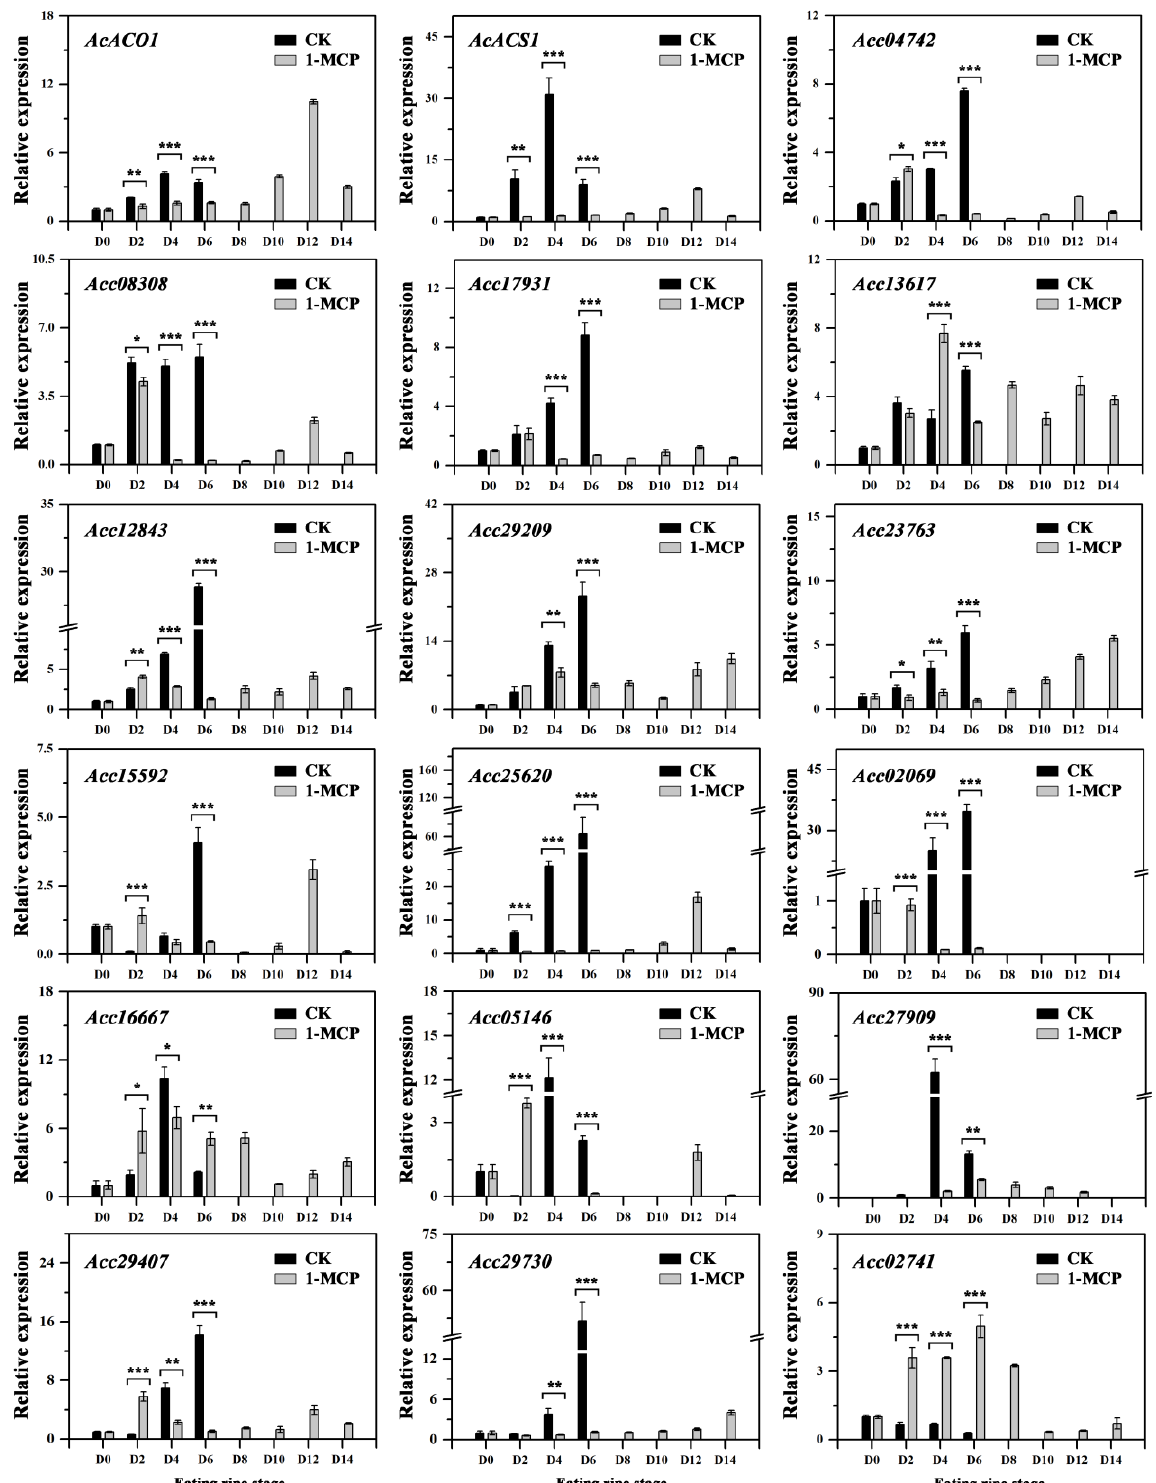
Figure 5. Expression of the ACO and ACS genes and ethylene-induced ERFs in the flesh of kiwifruit. Error bars show SE of the mean. Data were analyzed with Student’s t -test (* p < 0.05, ** p < 0.01, *** p < 0.001). It is well-known that the AP2/ERF transcription factors (TFs) play an important role in the response to 1-MCP treatment [6]. In this study, 153 individual AcAP2/ERF TFs were